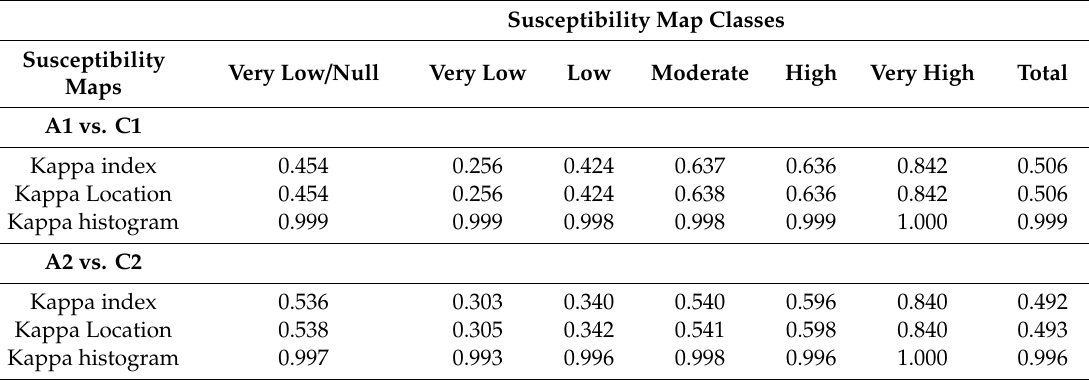
Table 5. Kappa values obtained by comparing the susceptibility Model A vs. Model C.